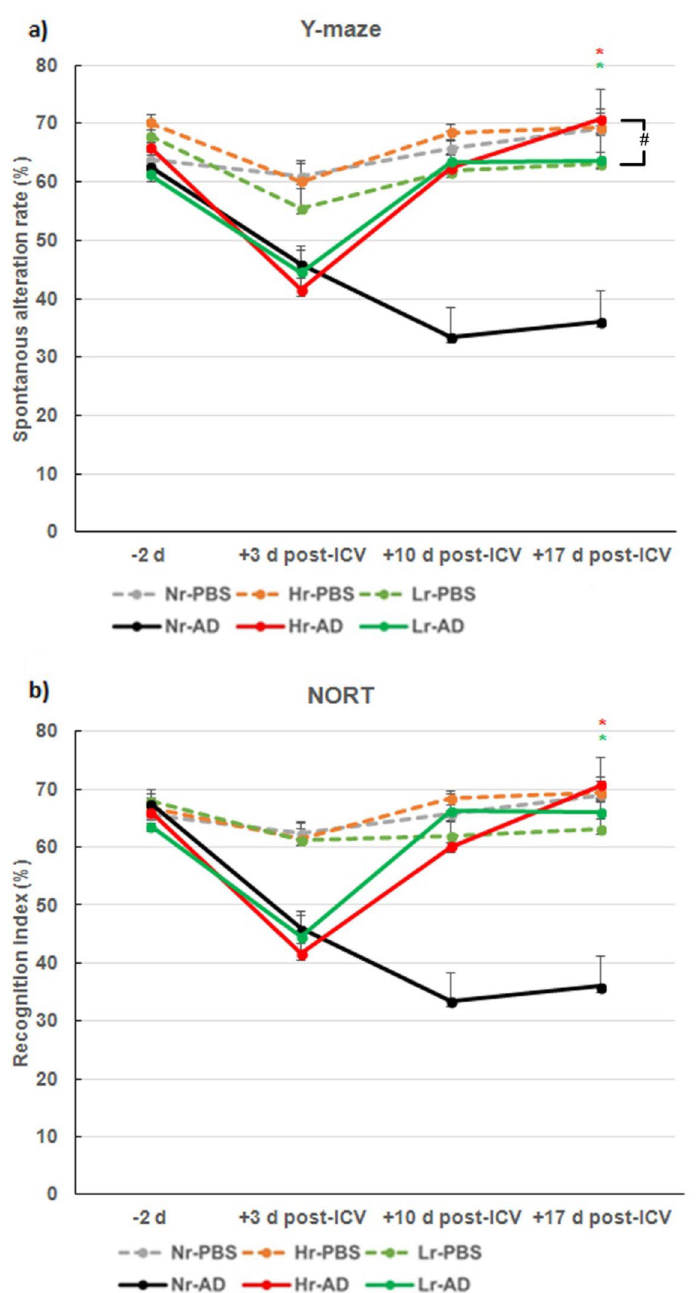
Figure 2. rTMS treatment up-regulates spatial working memory in the Y-maze test and recognition index of NORT in AD mouse model. ( a ) Spontaneous alternation rate over time by Y-maze test. ( b ) Recognition index over time by NORT. Each group n = 8, mean ± SEM. * Ps < 0.05; Hr-AD and Lr-AD compared to those in Nr-AD, # P = 0.06, Hr-AD compared to Lr-AD (Y-maze, F (2, 42) = 14.620, NORT, F (2, 42) = 11.017). rTMS repetitive transcranial magnetic stimulation, NORT novel object recognition task, AD Alzheimer’s disease model, ICV intracerebroventricular injection, NR− rTMS not treated, Hr − high frequency rTMS treated, Lr− low frequency rTMS treated, PBS Phosphate-Buffered